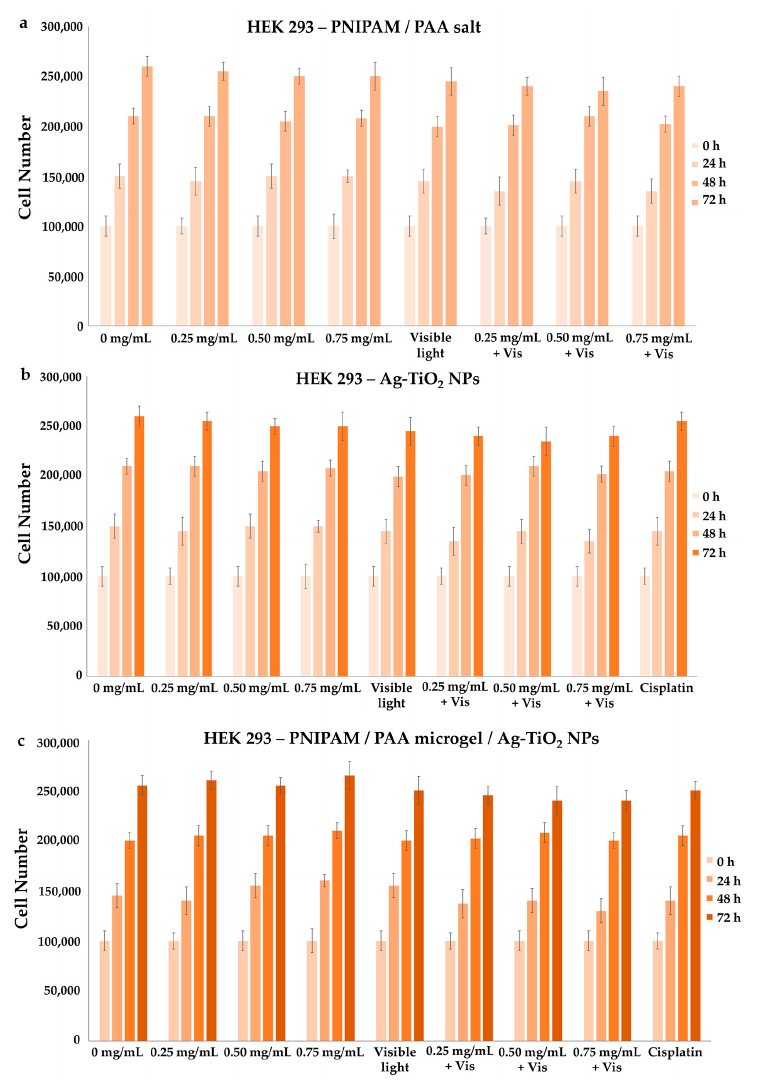
Figure 17. Growth rates of HEK293 cell line, with the addition of ( a ) PNIPAM/PAA salt, ( b ) Ag-TiO 2 NPs and ( c ) PNIPAM/PAA microgel/Ag-TiO 2 . There was no effect on cell proliferation, as the concentration of each of the tested materials increased. Additionally, irradiation with visible light did not affect their proliferation. In these series of experiments, p < 0.05 was considered statistically significant.